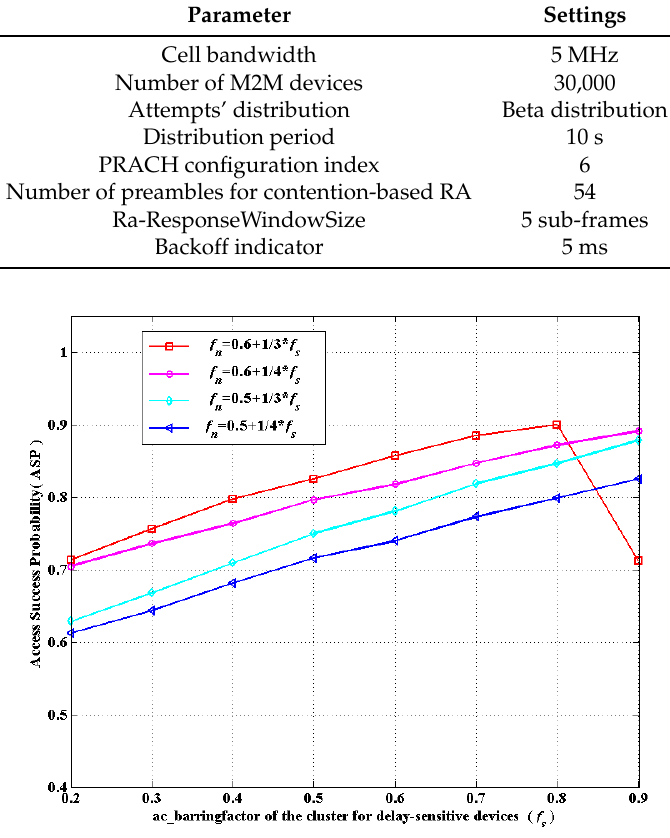
Figure 6. The ASP versus the linear correlation of f s and f n .